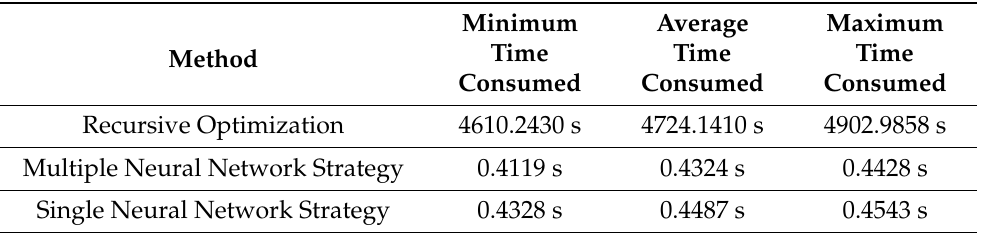
Table 2. Time Cost Information of the Measurement Kernel Design for a Single Measurement.